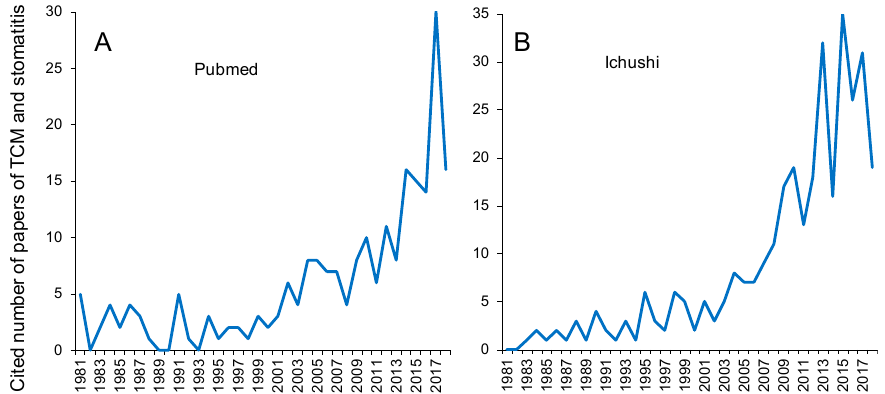
Figure 4. Increase of number of papers that cite TCM and stomatitis. ( A ): Data from Pubmed; ( B ): Data from Ichushi.